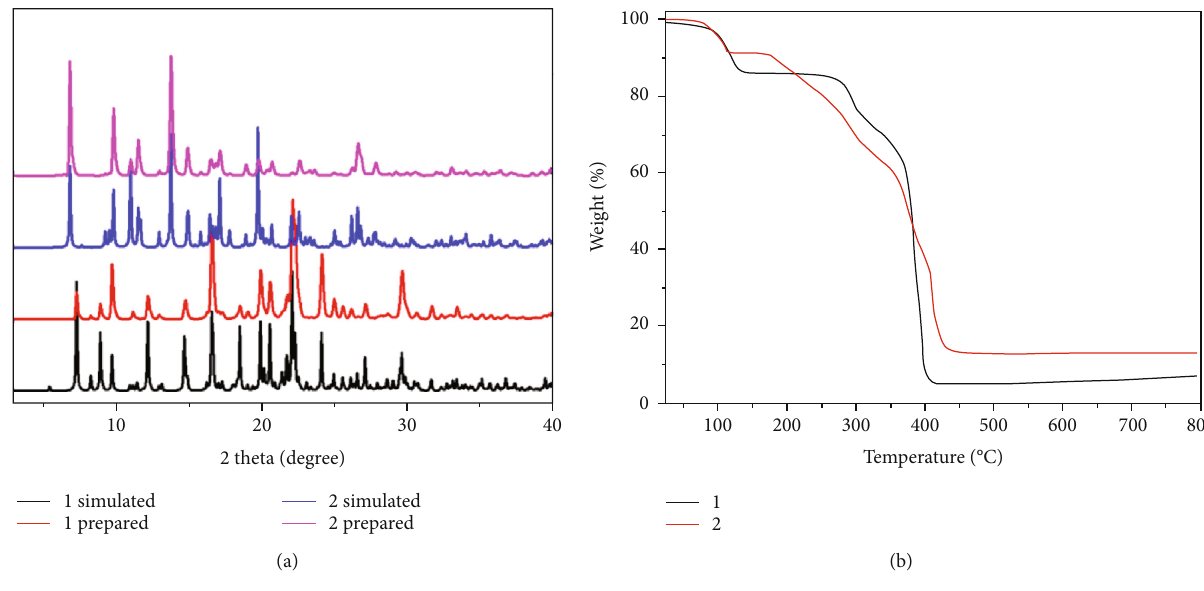
Figure 3: (a)The 1 ’ s pattern of PXRD. (b) and its TGA